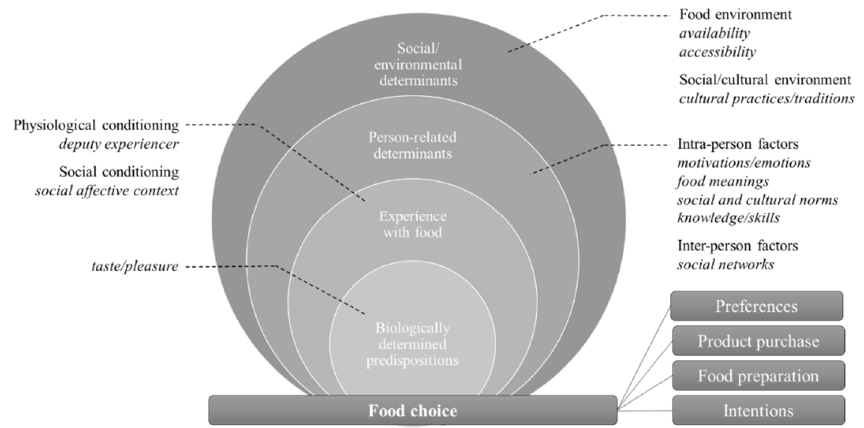
Figure 3. Food behavior variables of analog food choice linked to digital food communication. (adapted from Contento and Koch, 2021, p. 50).